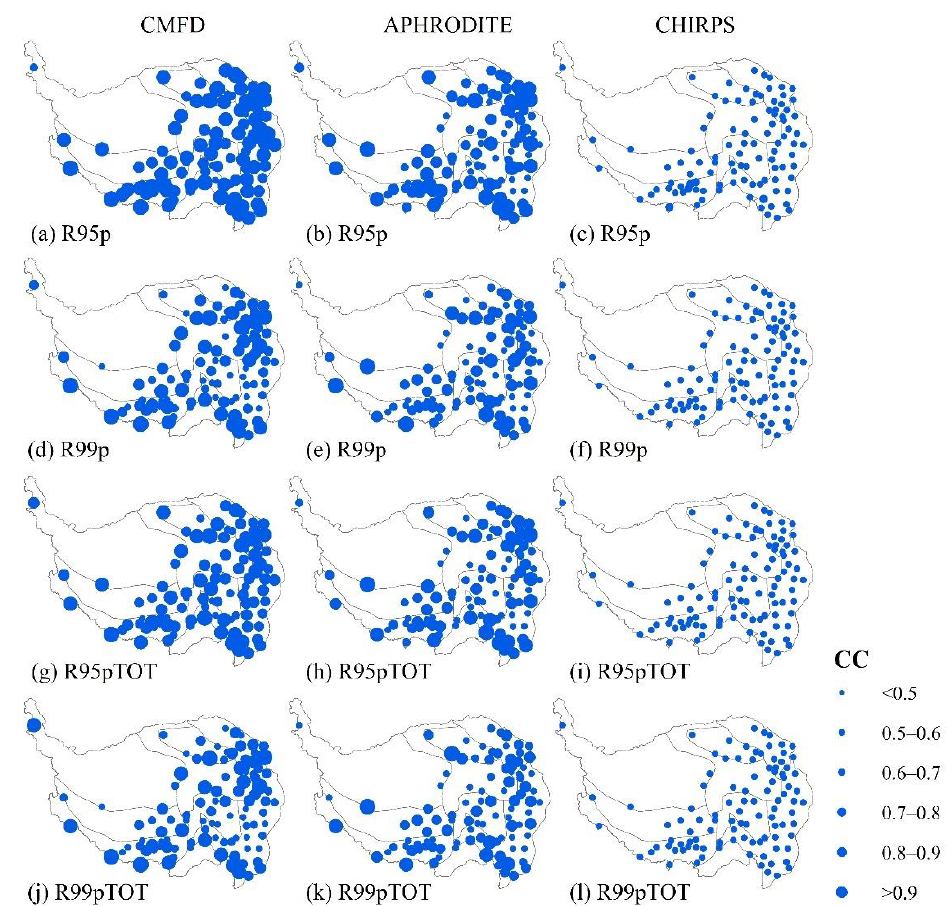
Figure 11. Correlations between gauge-based station threshold indices R95p, R99p, R95pTOT, and R99pTOT, as derived from CMFD, APHRODITE, and CHIRPS for the period 1981 – 2014.